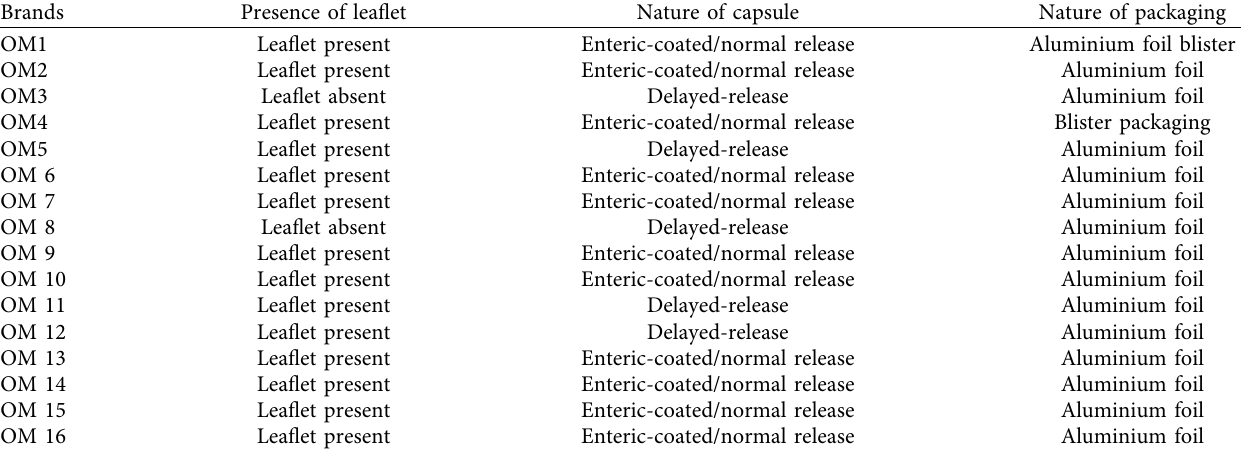
Table 2: Physical assessment of sampled